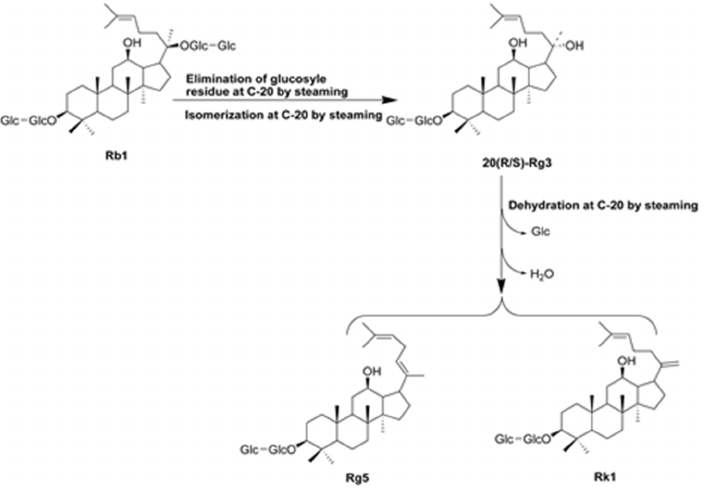
Figure 1. The chemical structure and possible transformation pathway of ginsenoside Rg5. Taking ginsenoside Rb1 as example to show the generation pathway of ginsenoside Rg5.